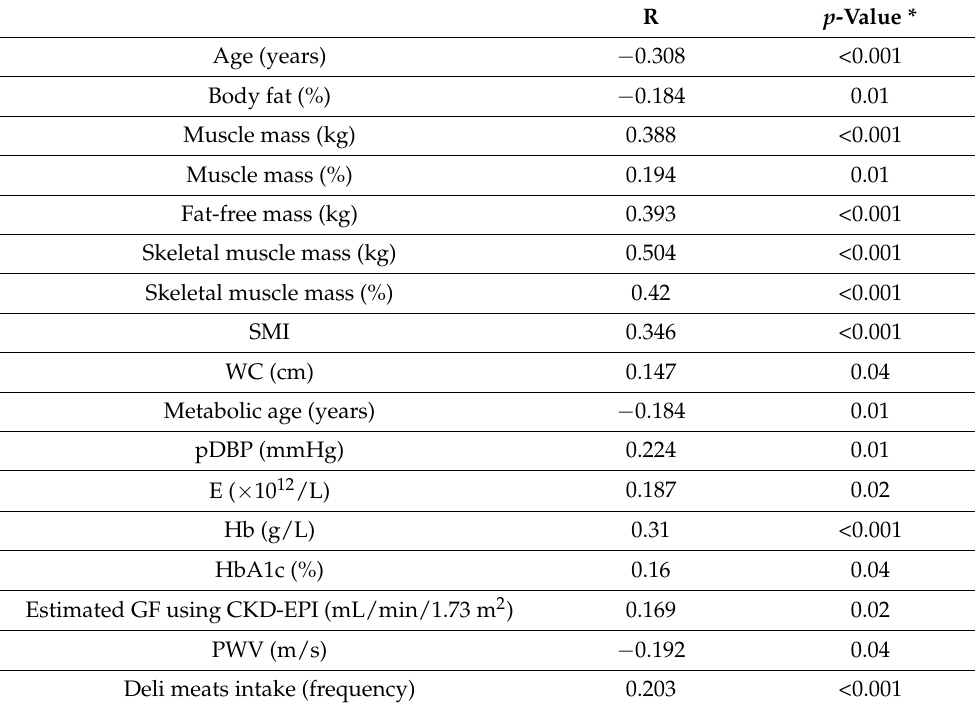
Table 3. Correlations between phase ‐ angle and measured parameters (only statistically significant parameters shown).